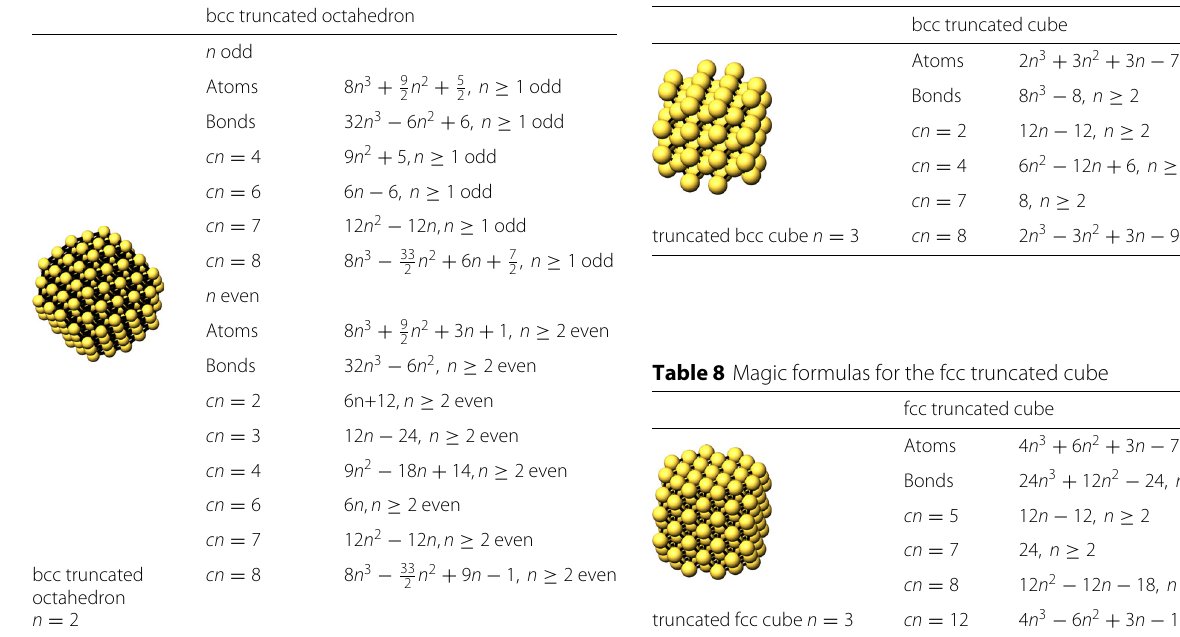
Table 7 Magic formulas for the bcc truncated cube